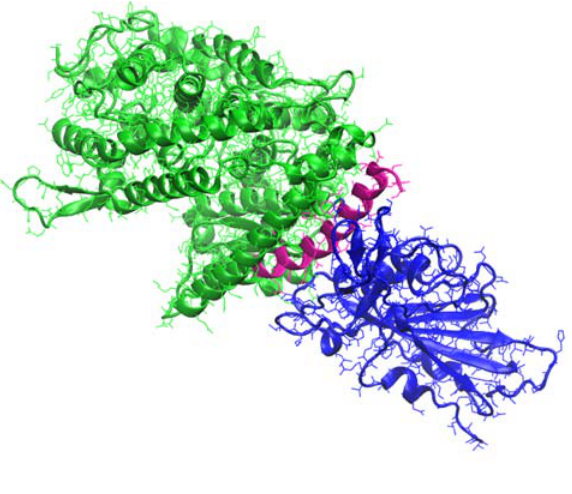
Fig. 1. Cartoon representation of the structure of the SARS­ CoV­2 spike protein S1 complex with ACE2, modelled computationally by using data listed in the PDB database (www.pdb.org) as “6LZG”. The spike protein is coloured blue, the ACE2 main body is coloured green and the binding domain α1 is coloured magenta.